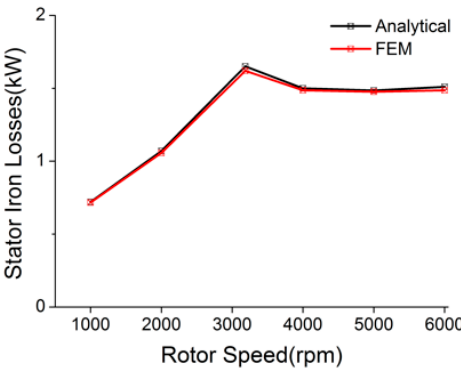
Figure 9. Calculated iron losses due to rotational speed. ( a ) Stator iron losses; ( b ) Ratio of the hysteresis losses and eddy current losses.